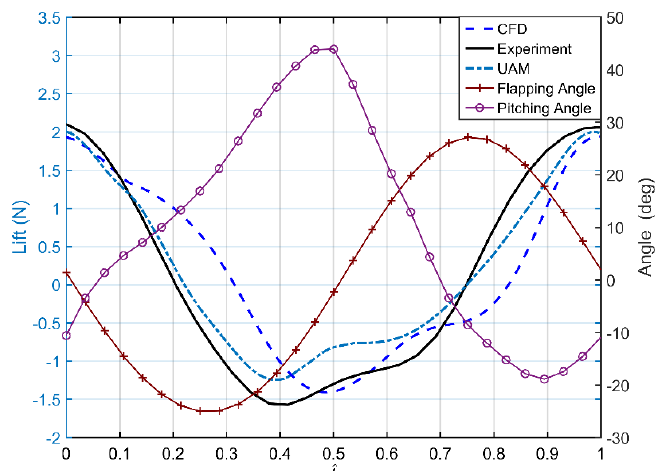
Figure 13. Flapping motion and lift forces by UAM, CFD and experiment (lift force obtained in experiments refers to the net vertical force; down-stroke: 𝑡̂ = 0~0.25; up-stroke: 𝑡̂ = 0.25~0.75; down-stroke: 𝑡̂ = 0.75~1).